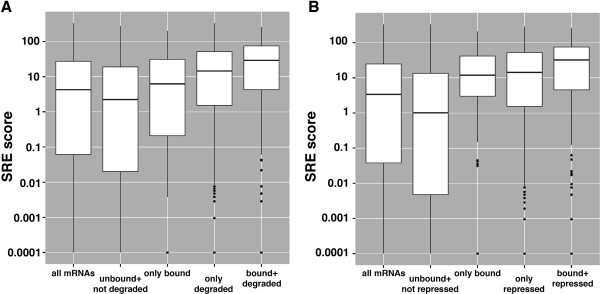
Smaug-degraded and Smaug-repressed mRNAs are enriched for SREs. (A) Genes were divided into one of four classes (see the main text for more details): 1) bound and degraded by Smaug; 2) neither bound nor degraded by Smaug; 3) only bound by Smaug; and 4) only degraded by Smaug. The range of SRE scores for these classes is shown in the box plots. (B) Genes were divided into one of four classes (see the main text for more details): 1) bound and translationally repressed by Smaug; 2) neither bound nor translationally repressed by Smaug; 3) only bound by Smaug; and 4) only translationally repressed by Smaug. The range of SRE scores for these classes is shown in the box plots. ‘All genes’ shows the range of SREs scores for all of the genes represented in (A) and (B), respectively.